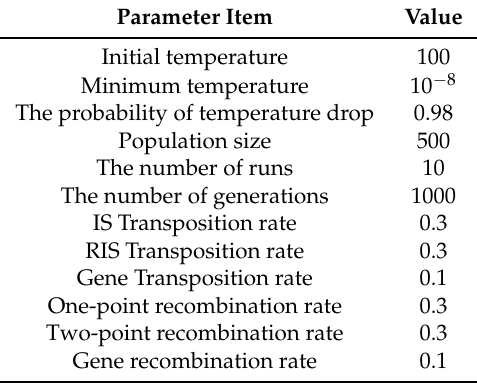
Table 2. Parameters of traveling-salesman problem based on simulated annealing and gene-expression programming